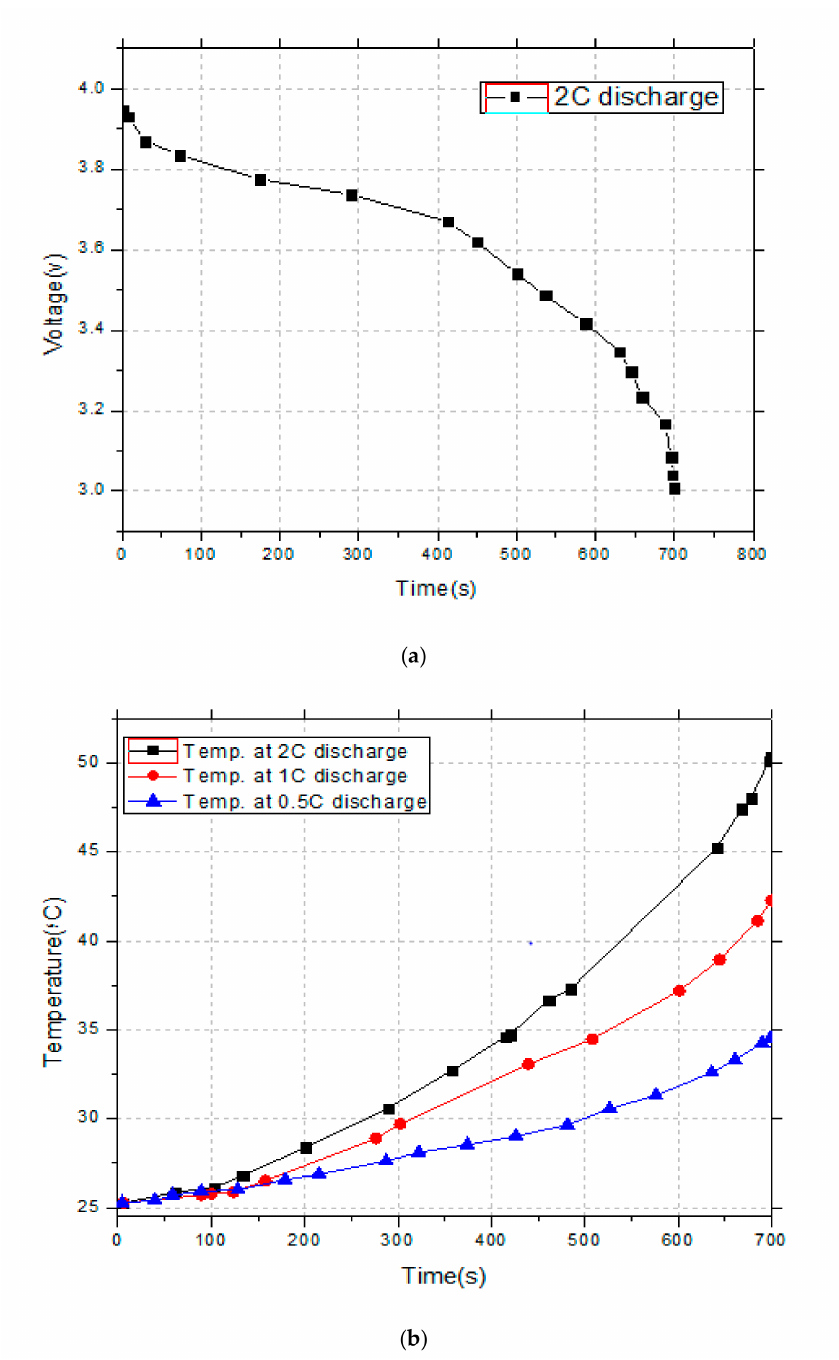
Figure 3. Temperature and voltage characteristics of the Li-ion battery: ( a ) Battery voltage during discharging at 2C rate; ( b ) Battery temperature rise during discharging at three di ff erent